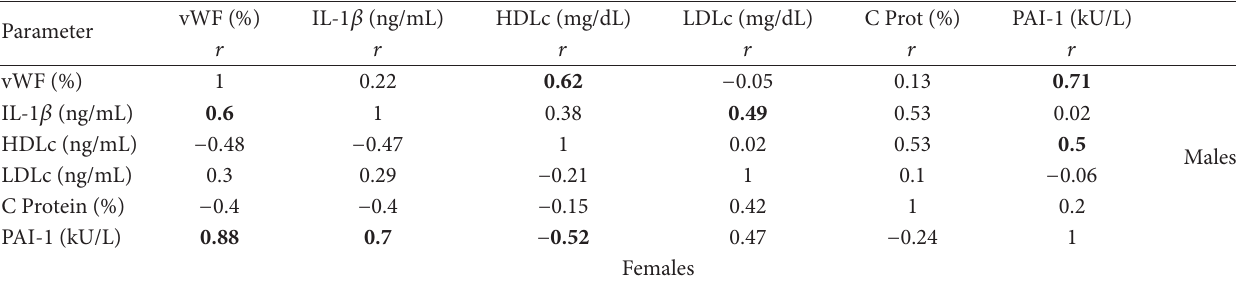
T 6: e correlation matrix between the monitored parameters in patients from non DM + IC group (according to the coefficient of Pearson correlation- 𝑟𝑟